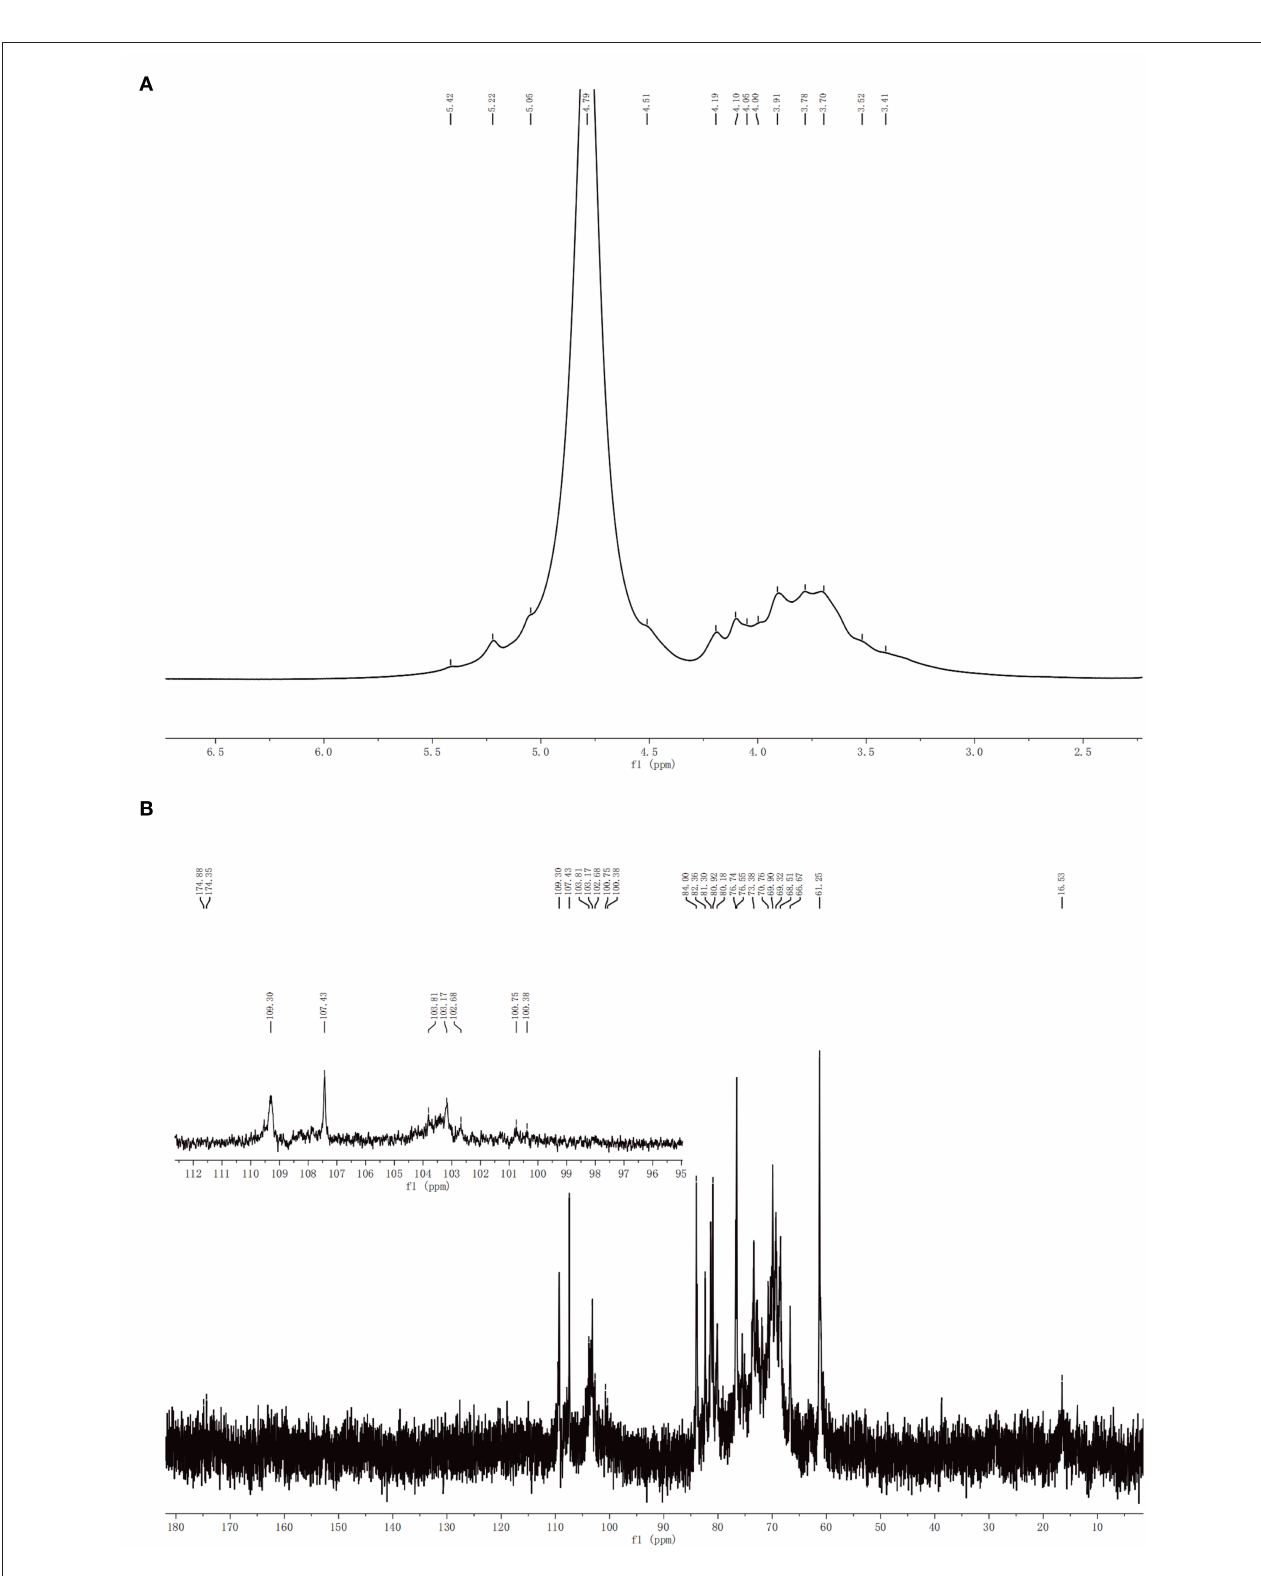
FIGURE 3 | 1 H (A) and 13 C (B) NMR spectra of CCP.